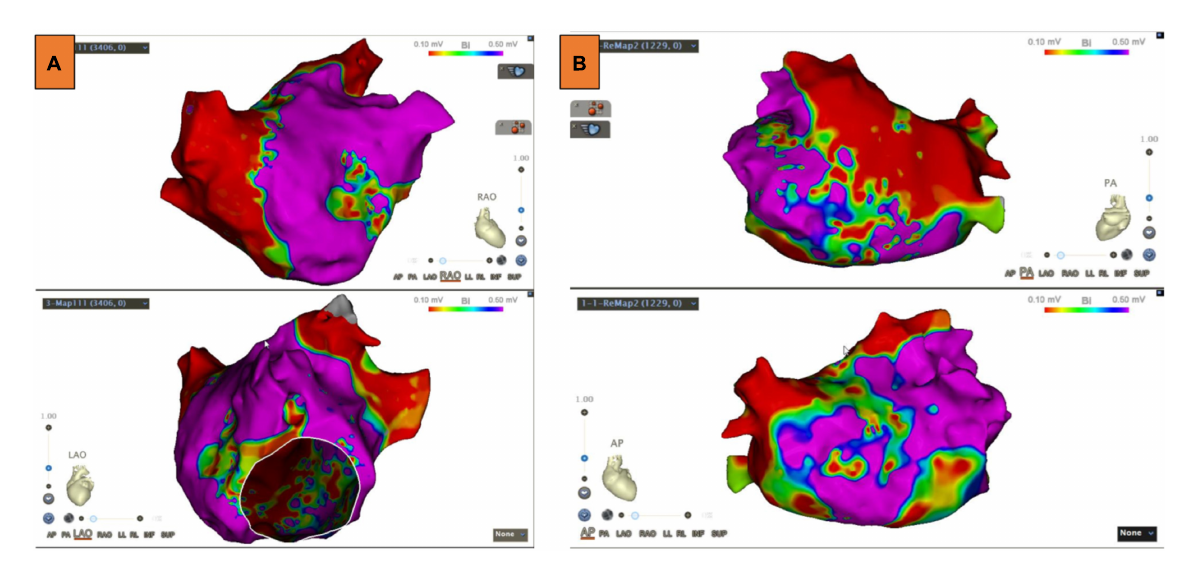
FIGURE2 Low voltage areas (LVAs) of the left atrium (LA). (A) LVAs were detected in the anterior wall of LA. (B) LVAs were detected in the roof and septal wall of LA. Substrate modification was performed in these areas, and an absolute bipolar electrogram of < 0.1 mV was achieved.